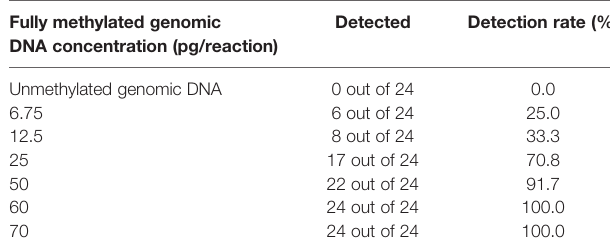
TABLE 2 | The analytical performance of m CLIP4